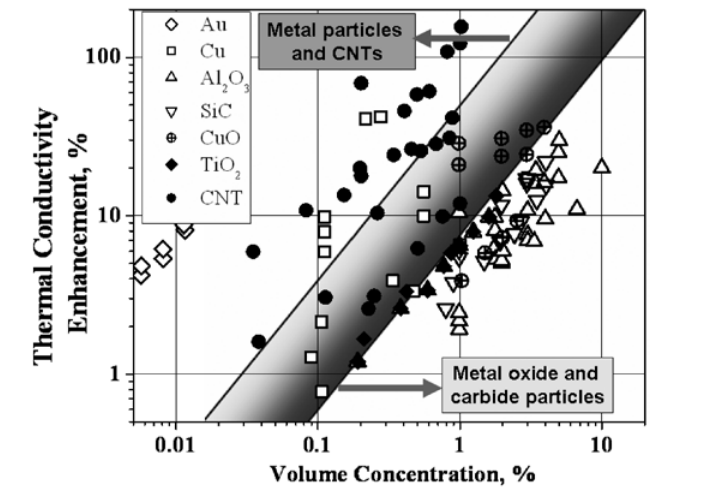
Fig. 1 Thermal conductivity of nanofluids: data taken from Lee et al. (1999), Eastman et al. (2001), Choi et al. (2001), Xie et al. (2002a & 2002b), Biercuk et al. (2002), Das et al. (2003a), Patel et al. (2003), Kumar et al. (2004), Wen and Ding (2004a, 2004b, 2005a, 2005b, 2006), Assael et al. (2004), Ding et al. (2006), He et al. (2007) and Zhang X et al.